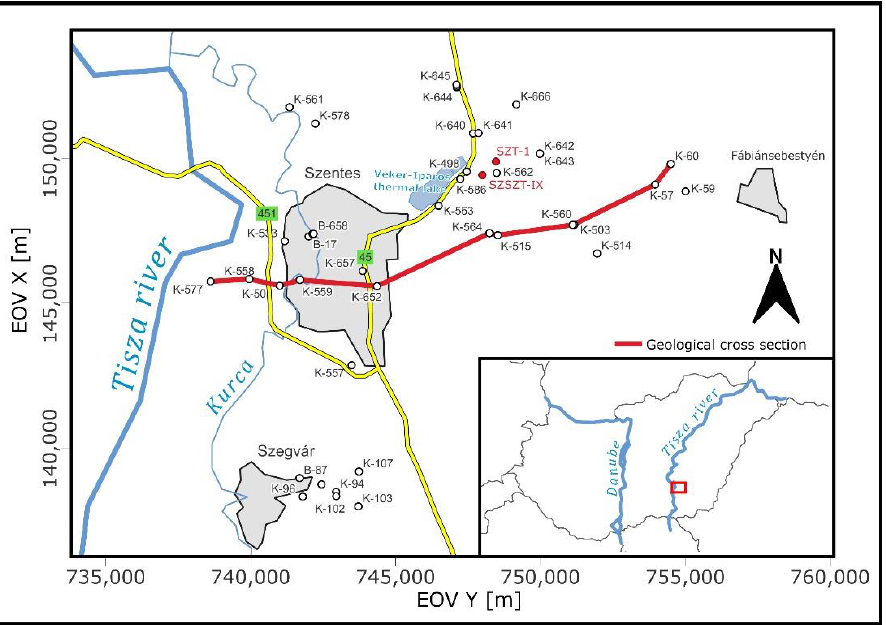
Figure 1. Location of the study area in Hungary, showing the active producing geothermal wells at the Szentes Geothermal Field. The wells “SZT-1” and “SZSZT-IX” (well IDs in red) were drilled in the framework of this study. The geological cross-section illustrates the stratigraphy of the study area in Section 2.3.